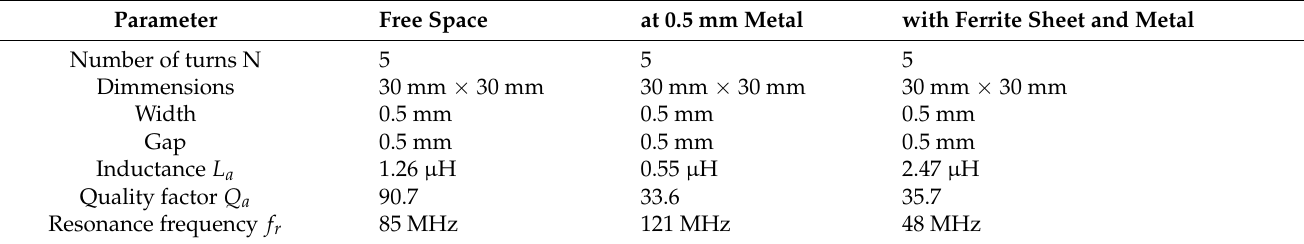
Table 1. Measured antenna parameters at 13.56 MHz at different